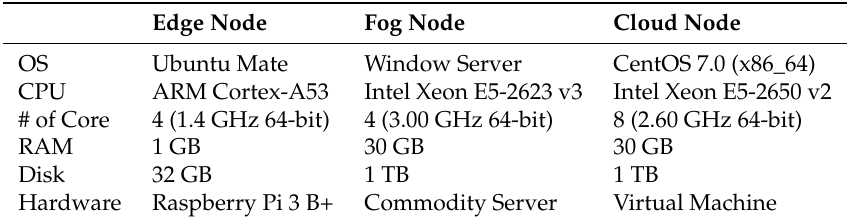
Table 1. The overview of the compute nodes.